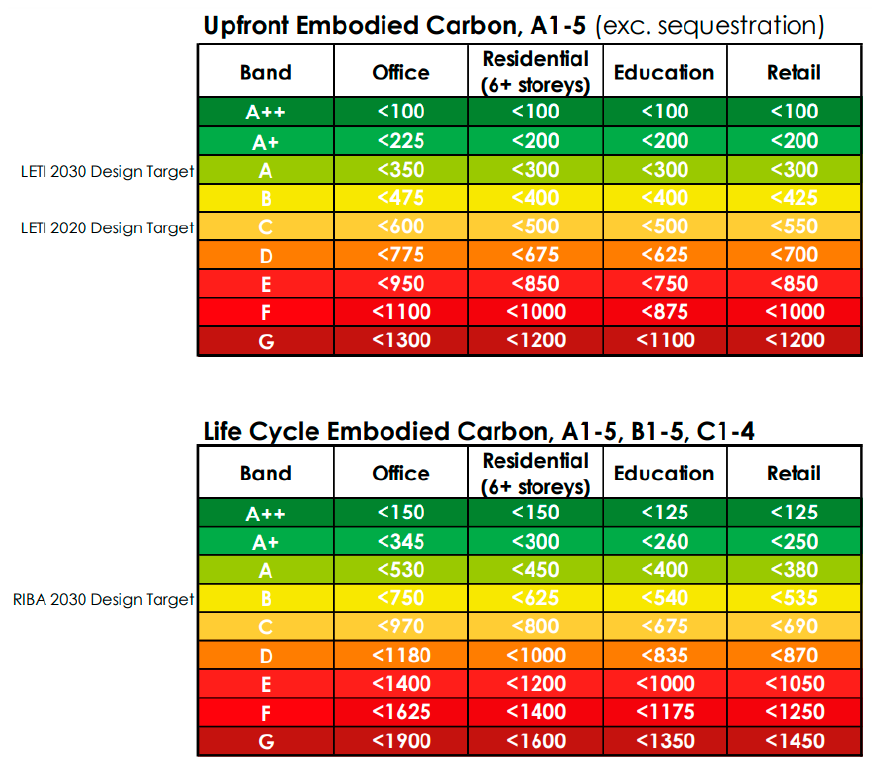
Energies 2023 , 16 , x FOR PEER REVIEW Figure 4. Whole Life Cycle Assessment Benchmarks by Building Type [17–19]. Figure 4. Whole Life Cycle Assessment Benchmarks by Building Type [17–19].